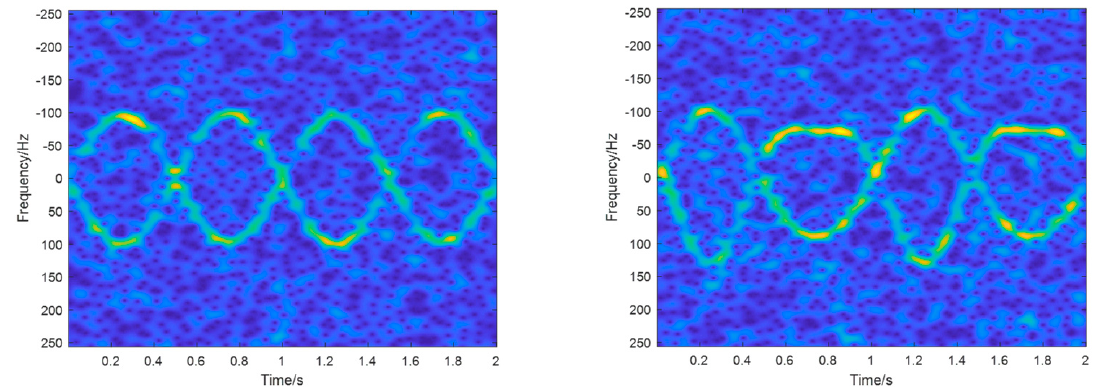
Figure 14. TFR of precession and